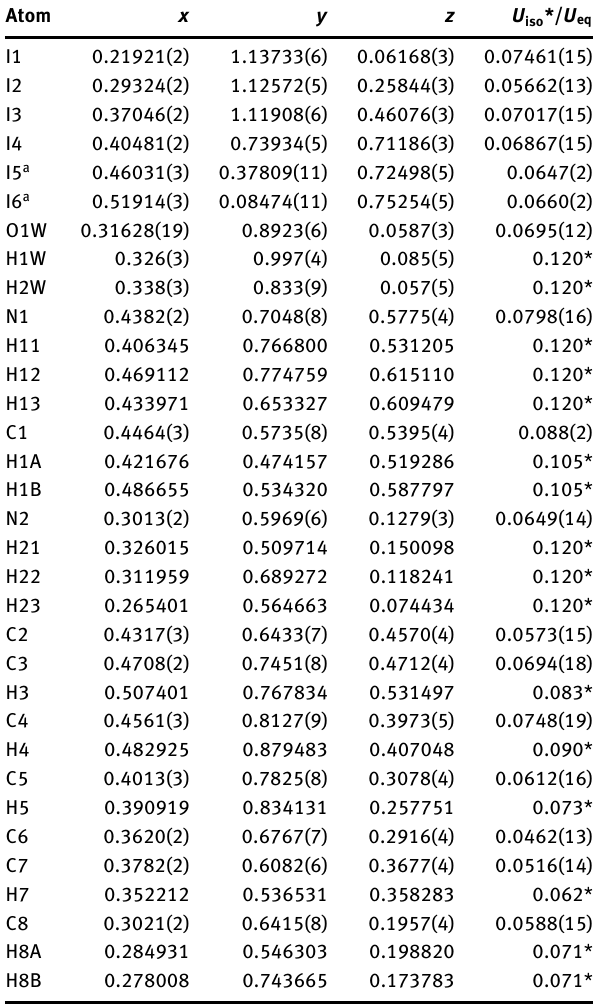
Table 2: Fractional atomic coordinates and isotropic or equivalent isotropic displacement parameters (Å 2